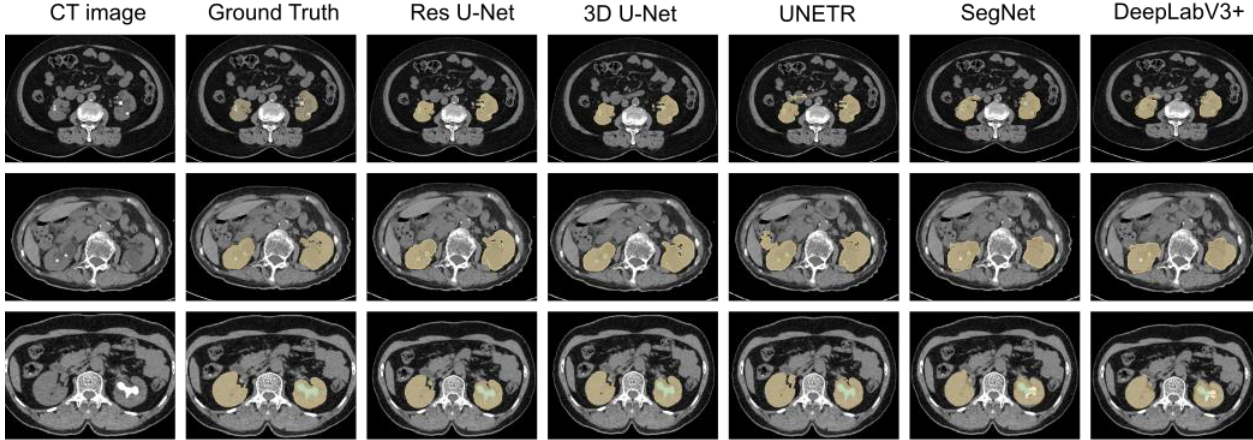
Figure 14. The 2D visual analysis of segmented kidneys and kidney stones predicted by the models trained dependently.